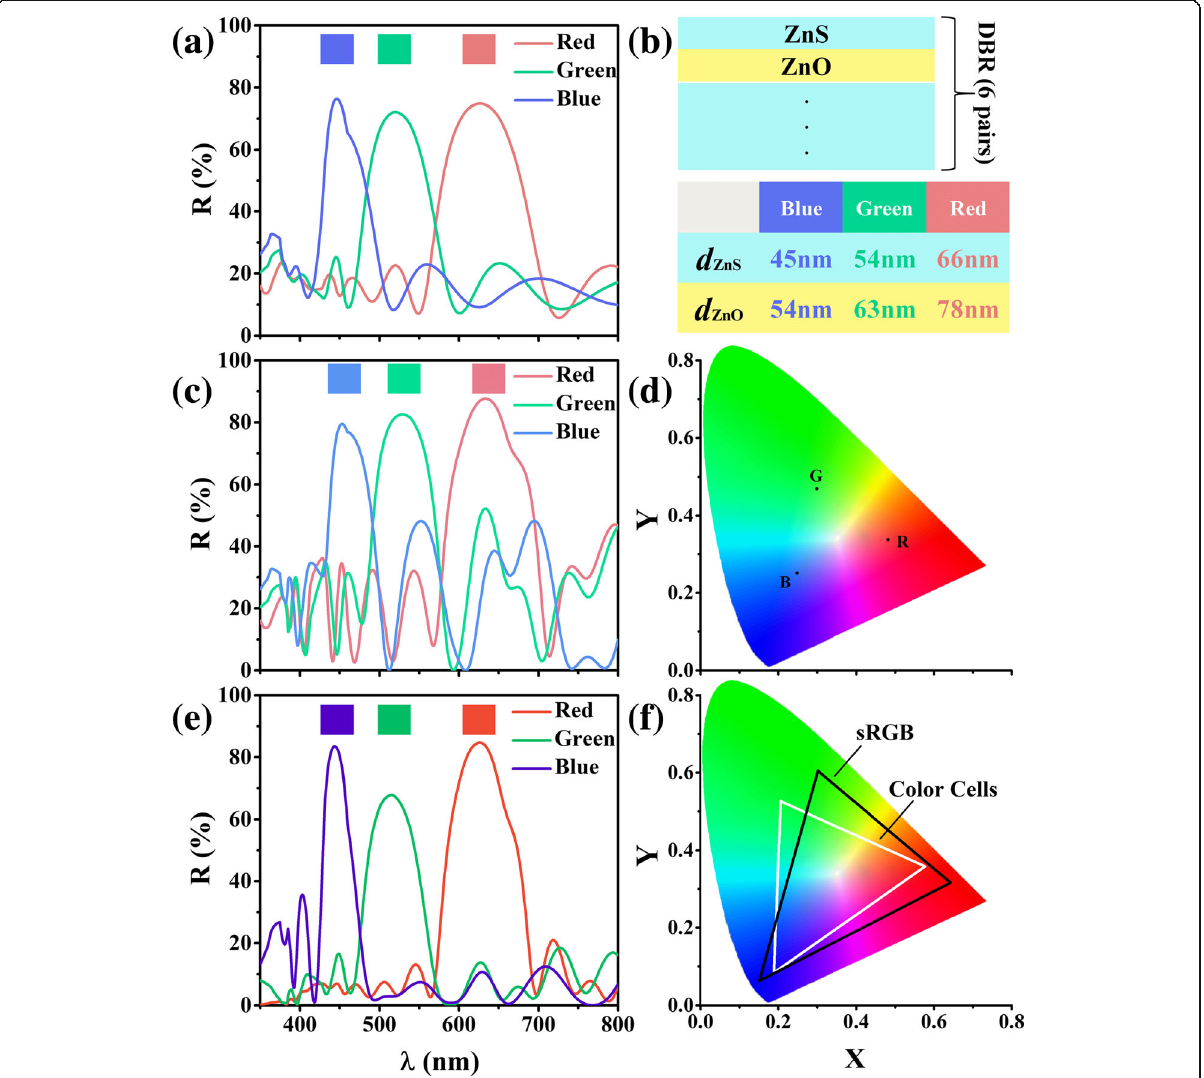
Fig. 2 Optical responses of DBRs and RGB a-Si:H SCs. a DBR reflection spectra targeting RGB display. b Structural and material parameters of the designed DBR. Reflectivity spectra ( c ) and the CIE 1931 chromaticity coordinates ( d ) of the a-Si:H SCs with RGB DBRs atop. Reflectance spectra ( e ) and the CIE 1931 chromaticity coordinates ( f ) of the designed color-controlled a-Si:H SCs. The standard sRGB color gamut is inserted in ( f ) for